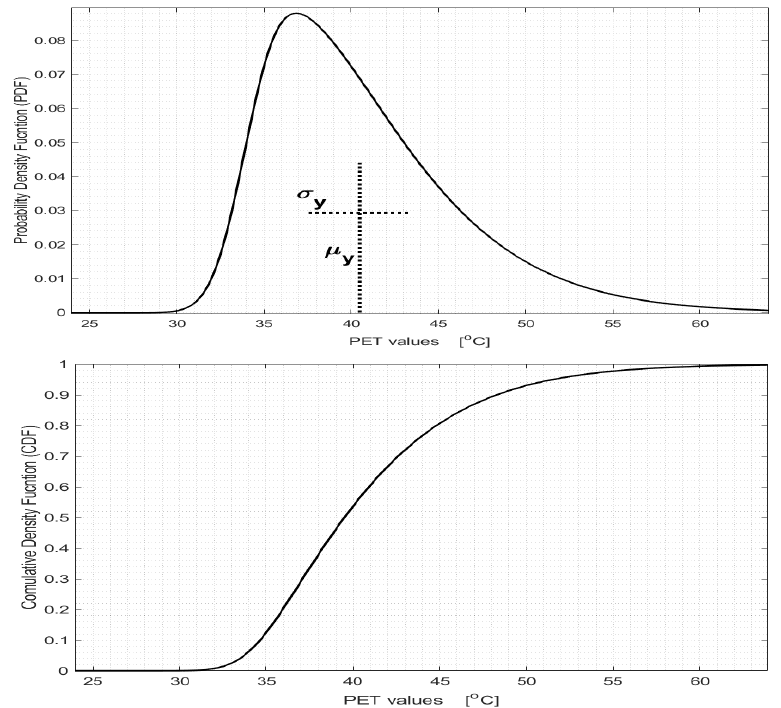
Figure 5. The PDF and CDF of the OTC index under climate model uncertainty. The mean, µ y , and variance, σ 2 y , are calculated according to Proposition